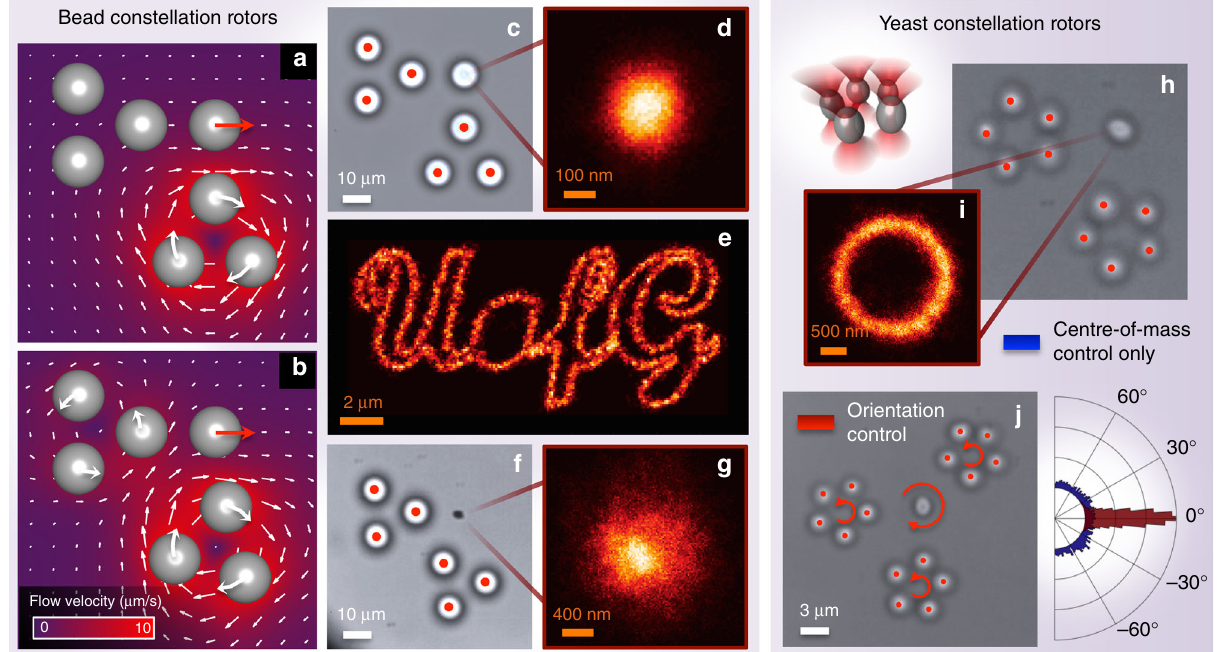
Fig. 4 Constellation rotors. a , b Modelled fl ow fi elds generated by three-bead (each of 5 μ m radius) constellation rotors. In a translation of the target in the positive x -direction is achieved by spinning just the lower rotor clockwise. In b the orientation of the lower rotor has changed. In this case, translation of the target in the positive x -direction requires actuation of both rotors. c Clamping of a 5 μ m radius silica bead using constellation rotors. d shows a 2D occupancy histogram of target positions during a 5 min period. e Translation of a 5 μ m radius silica bead along a complex trajectory tracing out the University of Glasgow logo, using constellation rotors. f Clamping of a chromium fragment. g shows a two-dimensional (2D) occupancy histogram of the trapped chromium fragment over a 30 min period. Yeast constellation rotors: h constellation rotors can also be assembled from yeast particles — even if their precise size is variable and unknown, as illustrated in the schematic top left. The small size (~2 – 3 μ m in diameter) of the yeast particles enables arrangement of fi ve optically trapped yeast in a ring. i Micro-manipulation of an individual yeast particle along a circular trajectory of 1 μ m radius over a period of 30 min, using yeast constellation rotors. Here while the centre of mass is controlled, the orientation of the target yeast is not. j Introduction of a third rotor enables control of target orientation as well as position: for example, spinning all rotors anti-clockwise rotates the target clockwise. To the right is a histogram of the orientations explored by the target in h (blue) and j